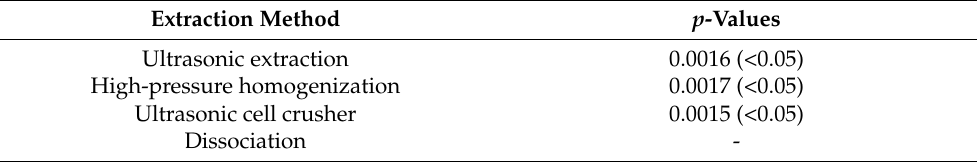
Figure 4. Recoveries of different extraction methods. Table 4. Statistical analysis of extraction methods.